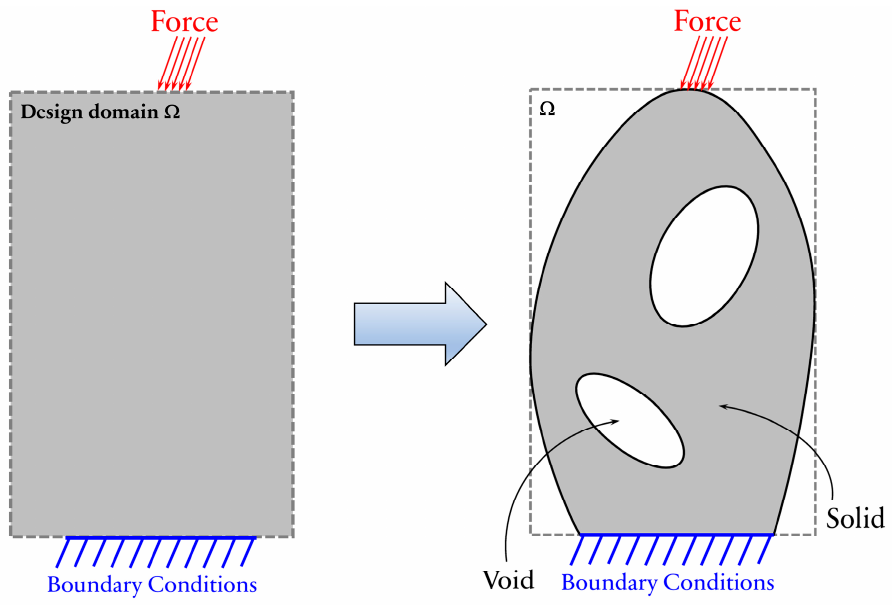
Figure 1. Typical topology/structural optimization under applied load and boundary conditions.